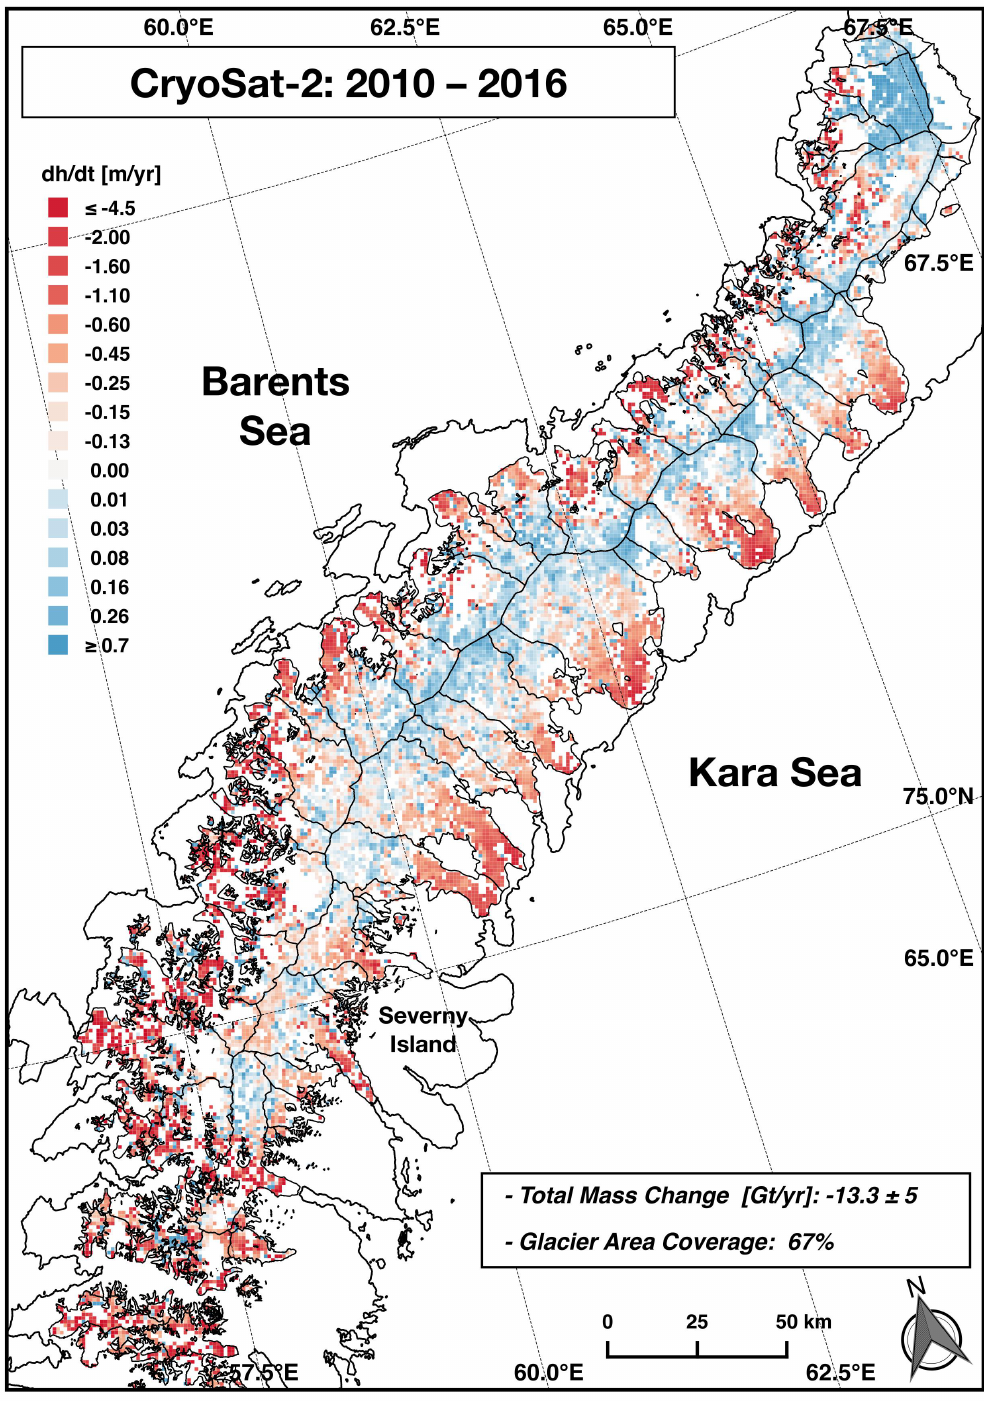
Figure 4. Map of ice elevation change for NZEM glaciers estimated using CryoSat-2 data for the time period July 2010–July 2016. Regional glacier outlines are extracted from the glacier inventory in Rastner et al.